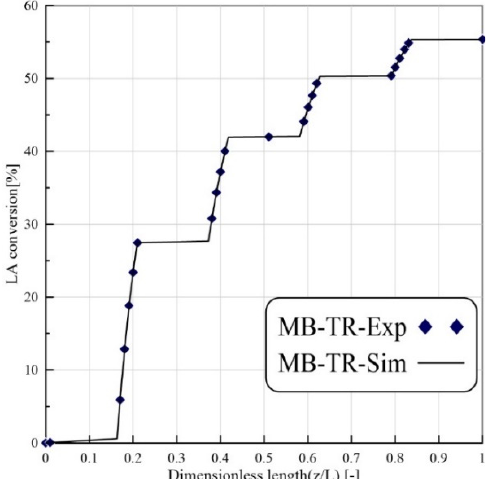
Figure 3. Comparison numerical results of EtLA production with experimental results achieved in Russo et al. [9] studies. Feed flow rate: 16.7 mm 3 /s, temperature: 333 K, and Et/LA = 1.